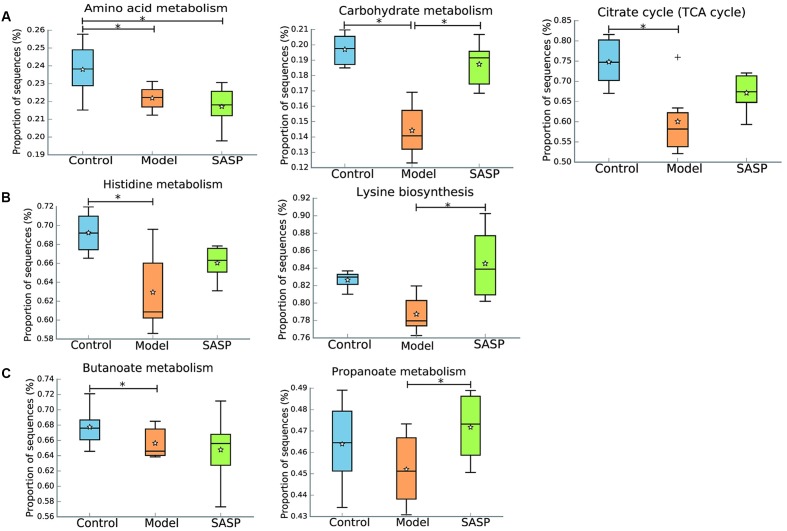
Inferred gut microbiome functions by PICRUSt from 16S rRNA gene sequences among the different three groups (the control group, the model group, and the SASP group). (A) Basic metabolism including amino acid metabolism, carbohydrate metabolism, and citrate cycle. (B) The metabolism and biosynthesis of amino acids, including histidine metabolism and lysine biosynthesis. (C) SCFA production including propanoate and butanoate metabolism. Box plots denote the top quartile, median and bottom quartile, and white stars mean the average value as well as the ‘+’ means the outlier. All the differences were analyzed using one-way ANOVA followed by Tukey–Kramer post hoc test, Benjamini–Hochberg FDR method was used to correct multiple comparisons (∗P < 0.05).